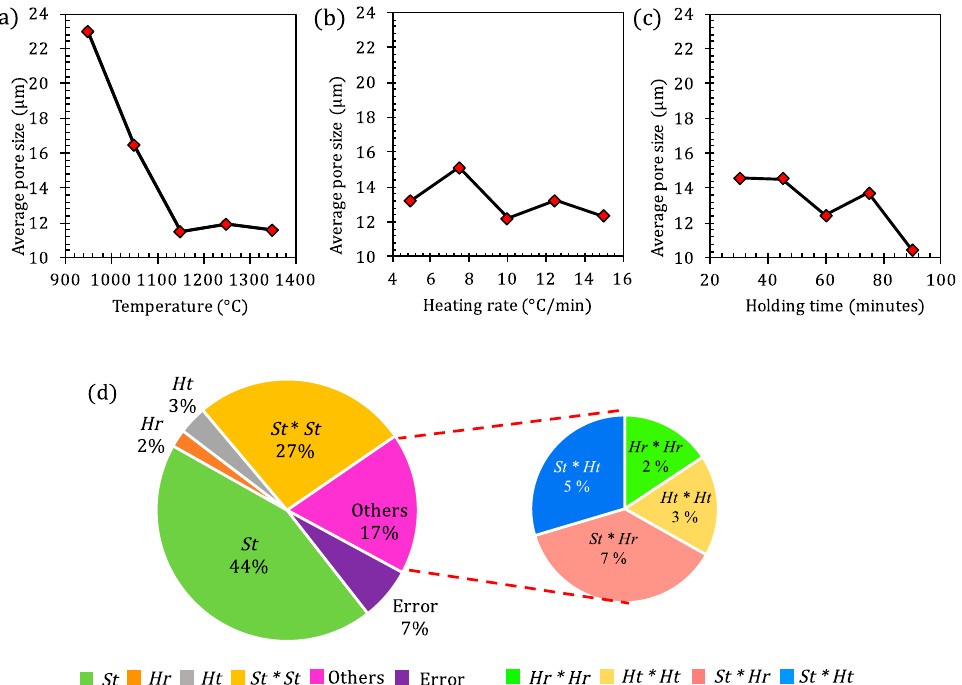
Figure 6. Main effect plots for average pore size: ( a ) Pore size versus temperature; ( b ) pore size versus heating rate; ( c ) pore size versus holding time; and ( d ) percentage contribution of linear, square, and interaction terms in the process.